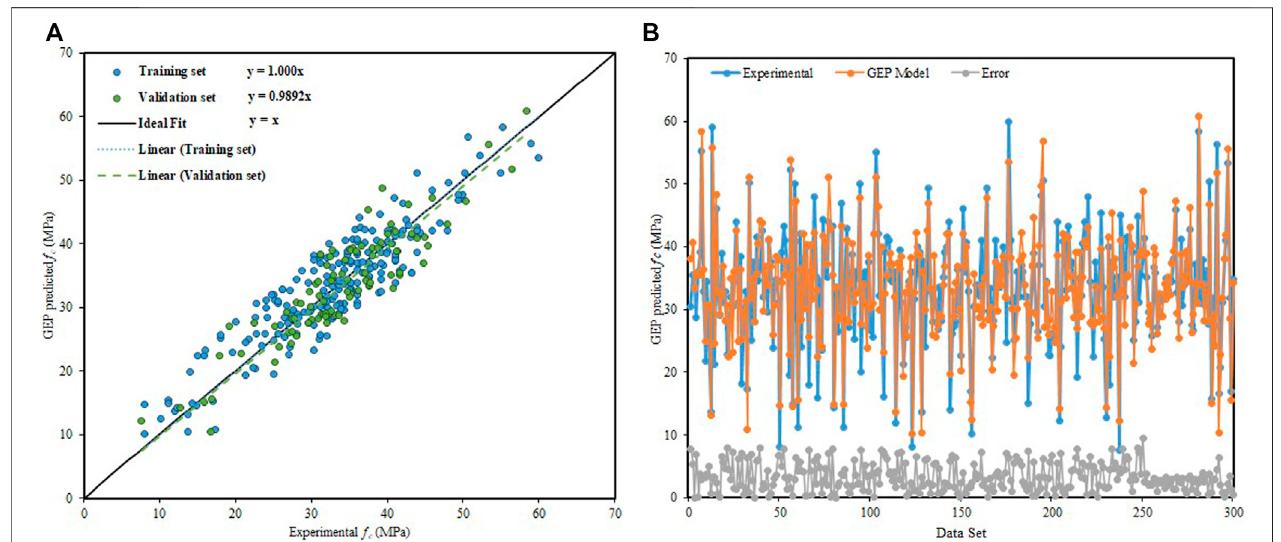
FIGURE 8 | GEP model predictive results. (A) Regression line slope of the GEP model. (B) Dispersion of absolute error values of the GEP model.